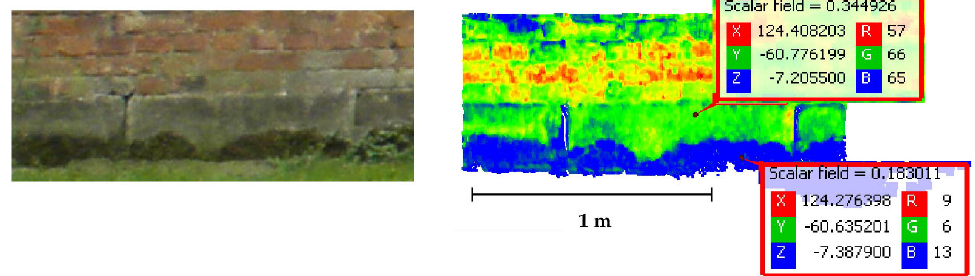
Figure 7. Detection of biological corrosion of the wall based on intensity value analysis.